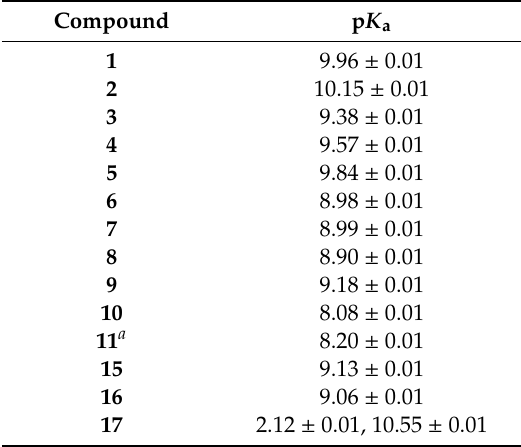
Table 2. p K a values of compounds investigated herein.